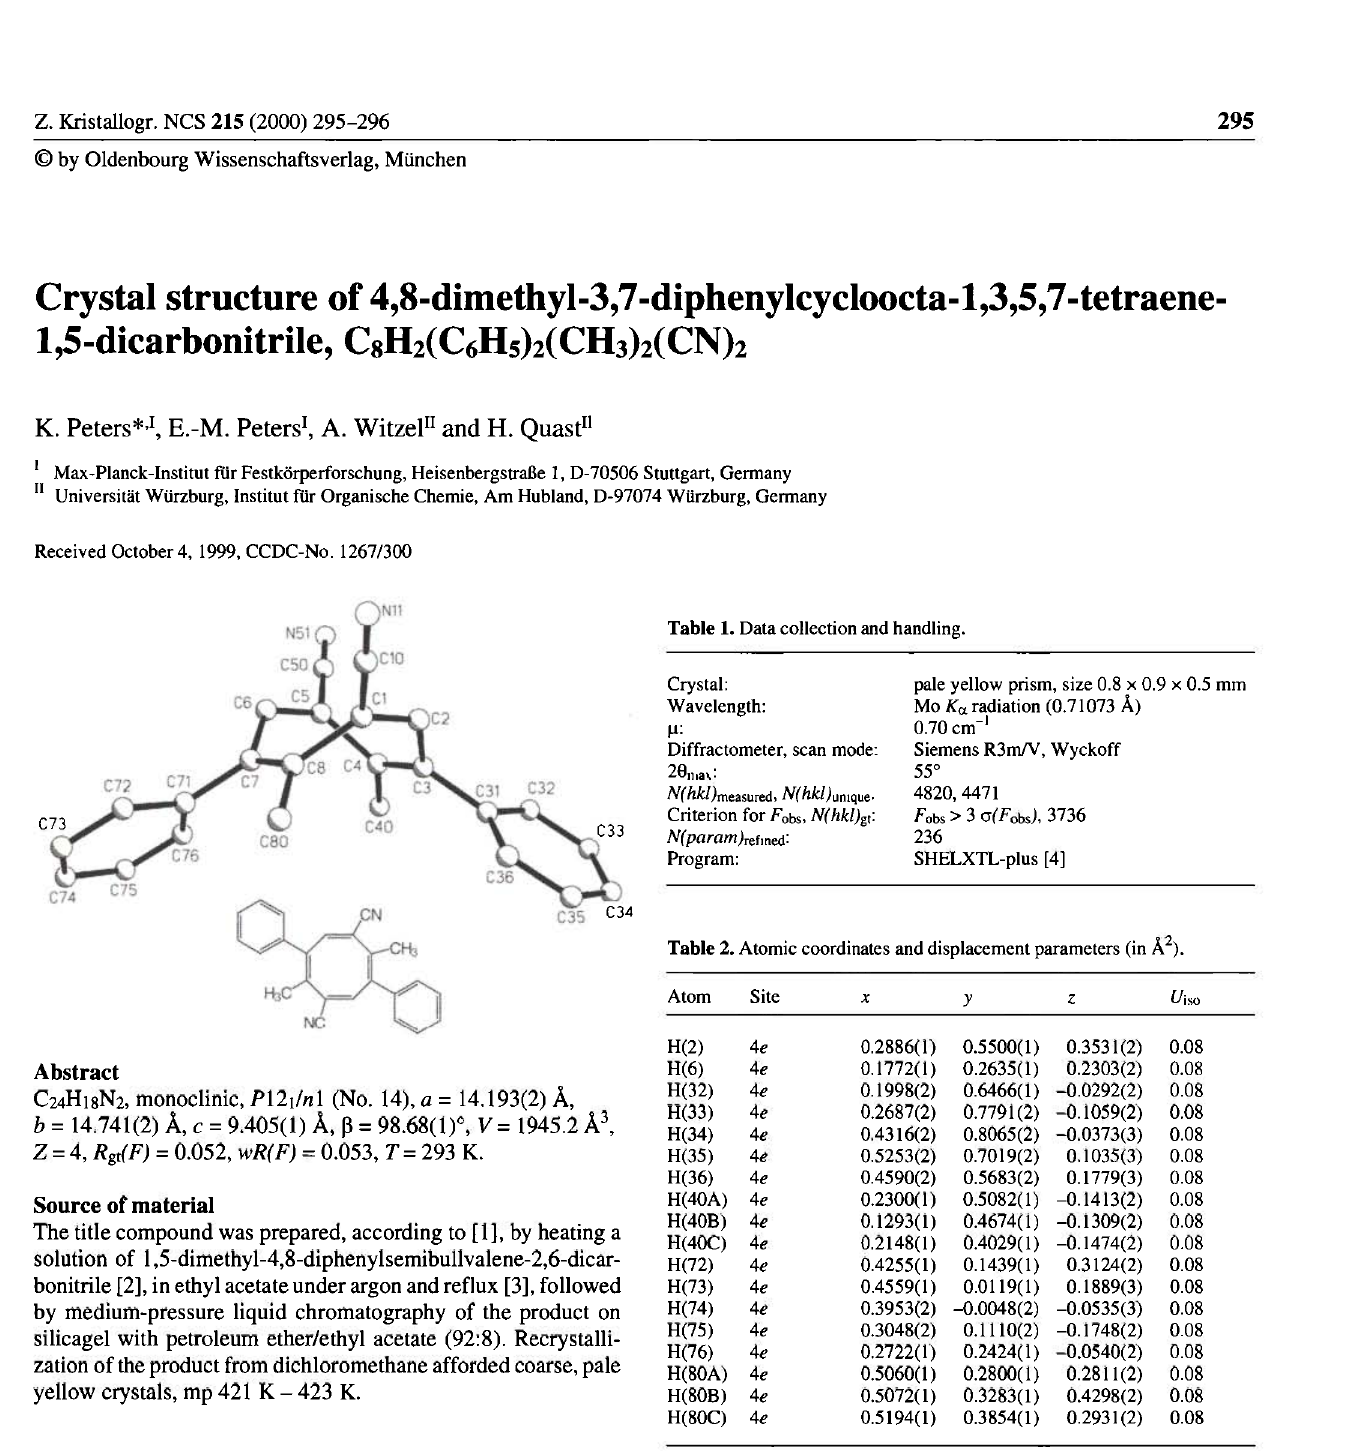
Table 3. Atomic coordinates and displacement parameters (in Ä 2 ).